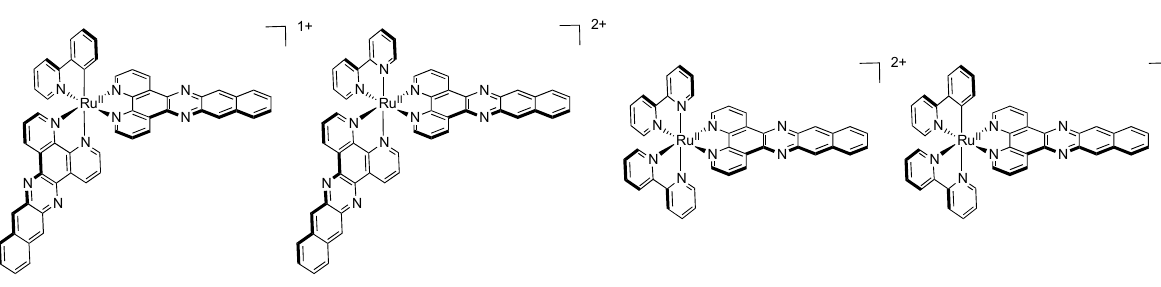
Figure 17. Ruthenium II complexes bearing dppn, bpy and ppy